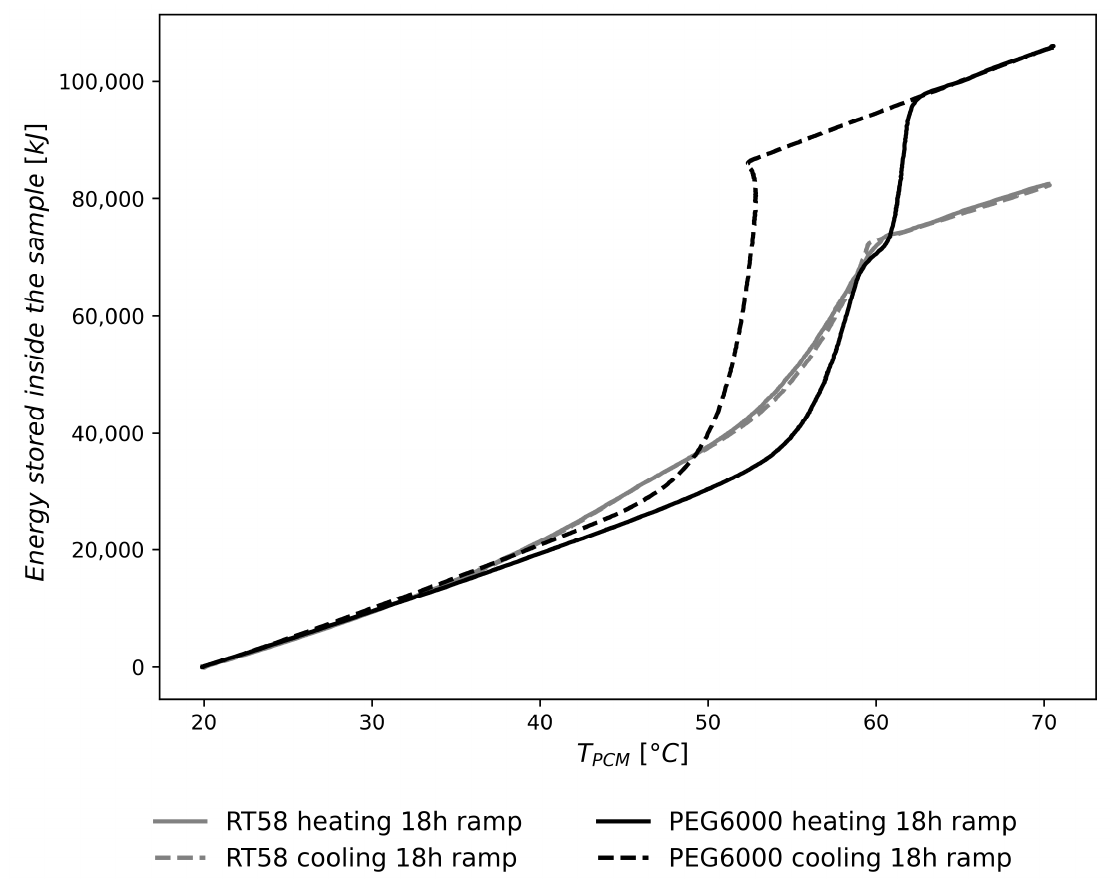
Figure 10. Energy stored inside the sample (PMMA brick + PCM) as a function of the PCM temperature for the 18 h heating/cooling ramp.